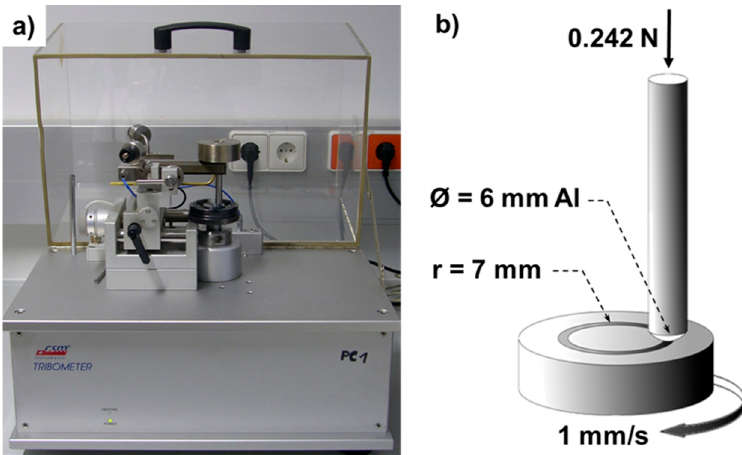
Figure 1. Photograph of the utilized tribometer ( a ) and a sketch of the tested pairs ( b ).